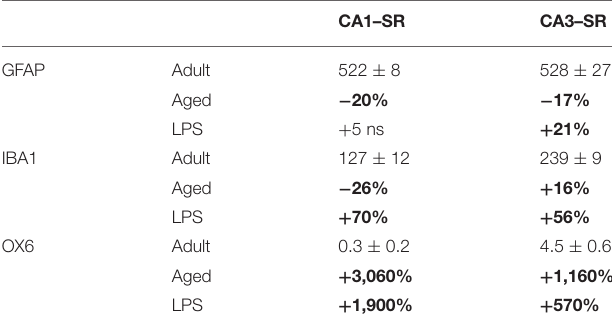
TABLE 1 | Astrocytes and microglia responses to the same insult are not uniform, but in different stress conditions vary significantly from region to